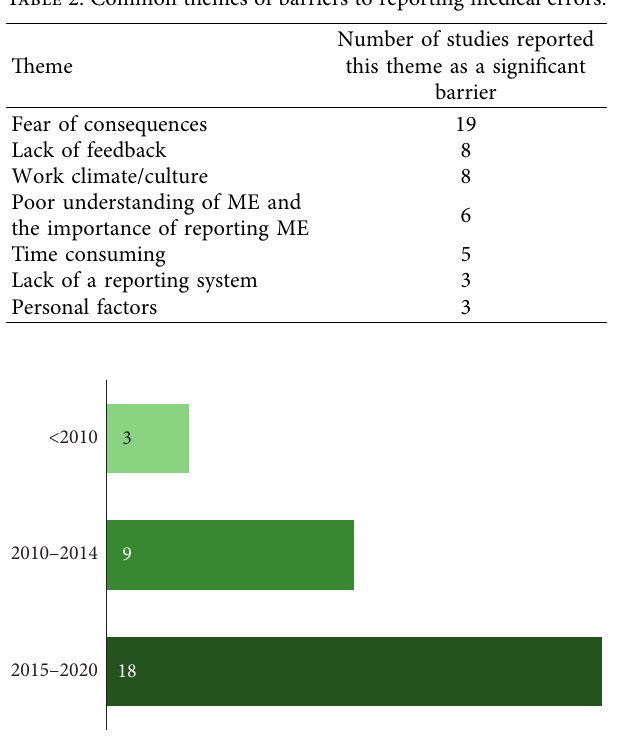
Table 2: Common themes of barriers to reporting medical errors.